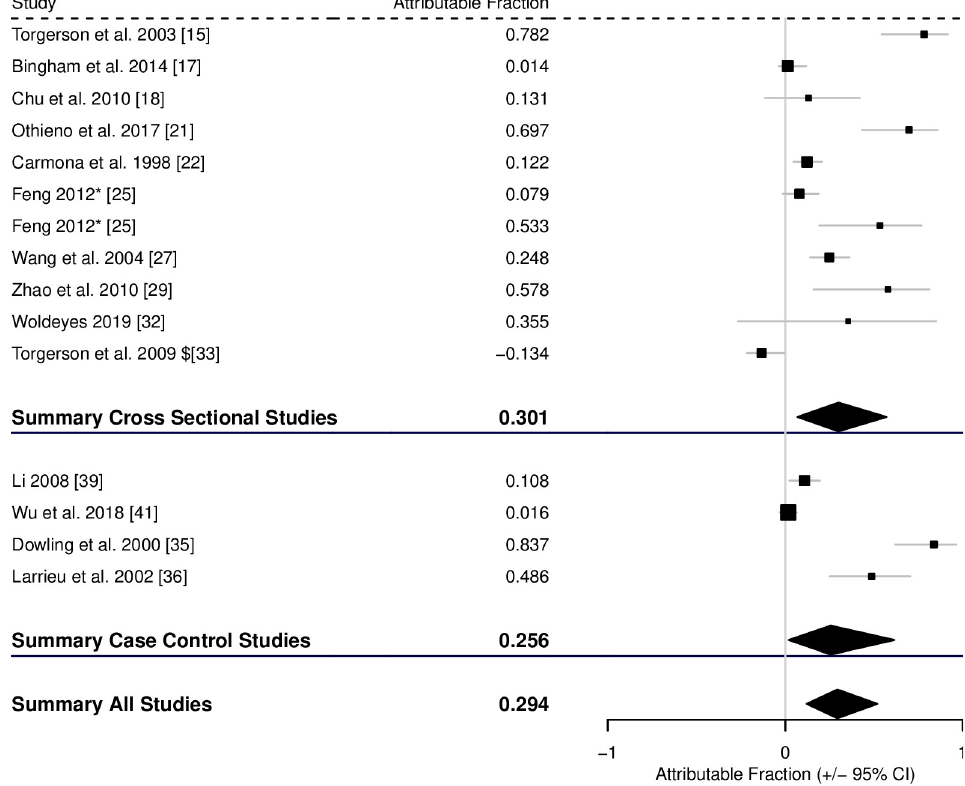
Fig 4. Forest plot for the attributable fraction for 11 cross-sectional studies and 4 case-control that analysed contaminated water as a potential risk factor for CE. $ Indicates different studies in the same published report the same source. � Data not reported in study, but supplied by the